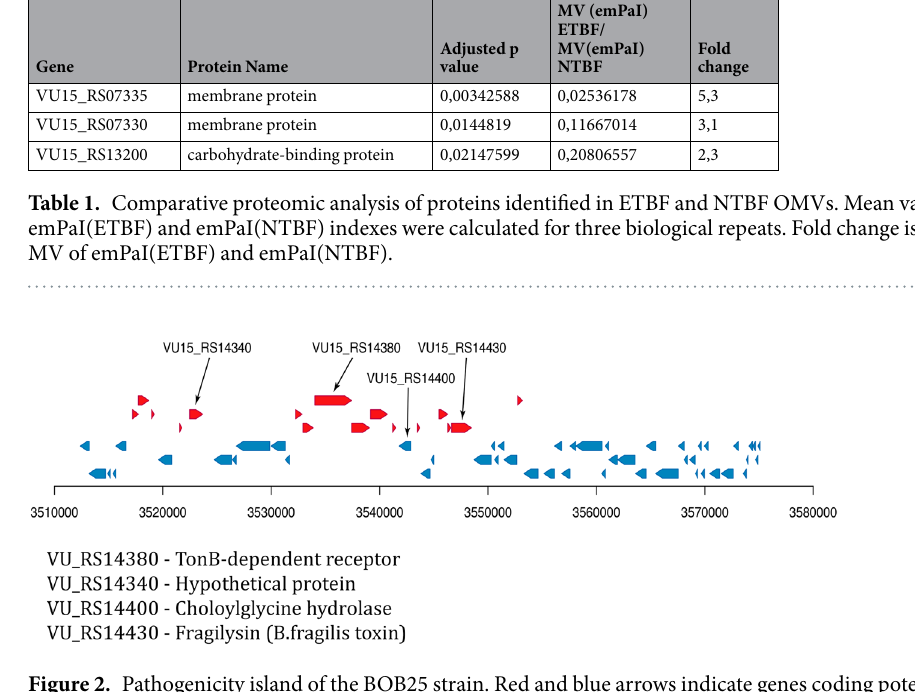
Figure 2. Pathogenicity island of the BOB25 strain. Red and blue arrows indicate genes coding potential virulence factors. Black arrows indicate the virulence factors, identified in ETBF